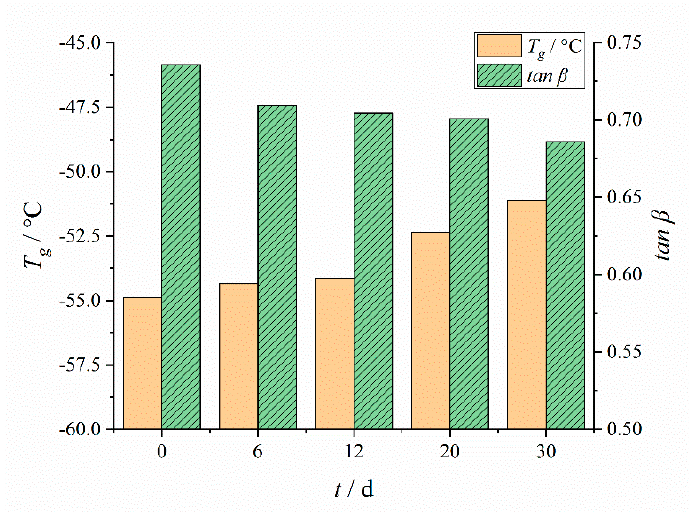
Figure 6. Changing results of T g and tan β with aging time.